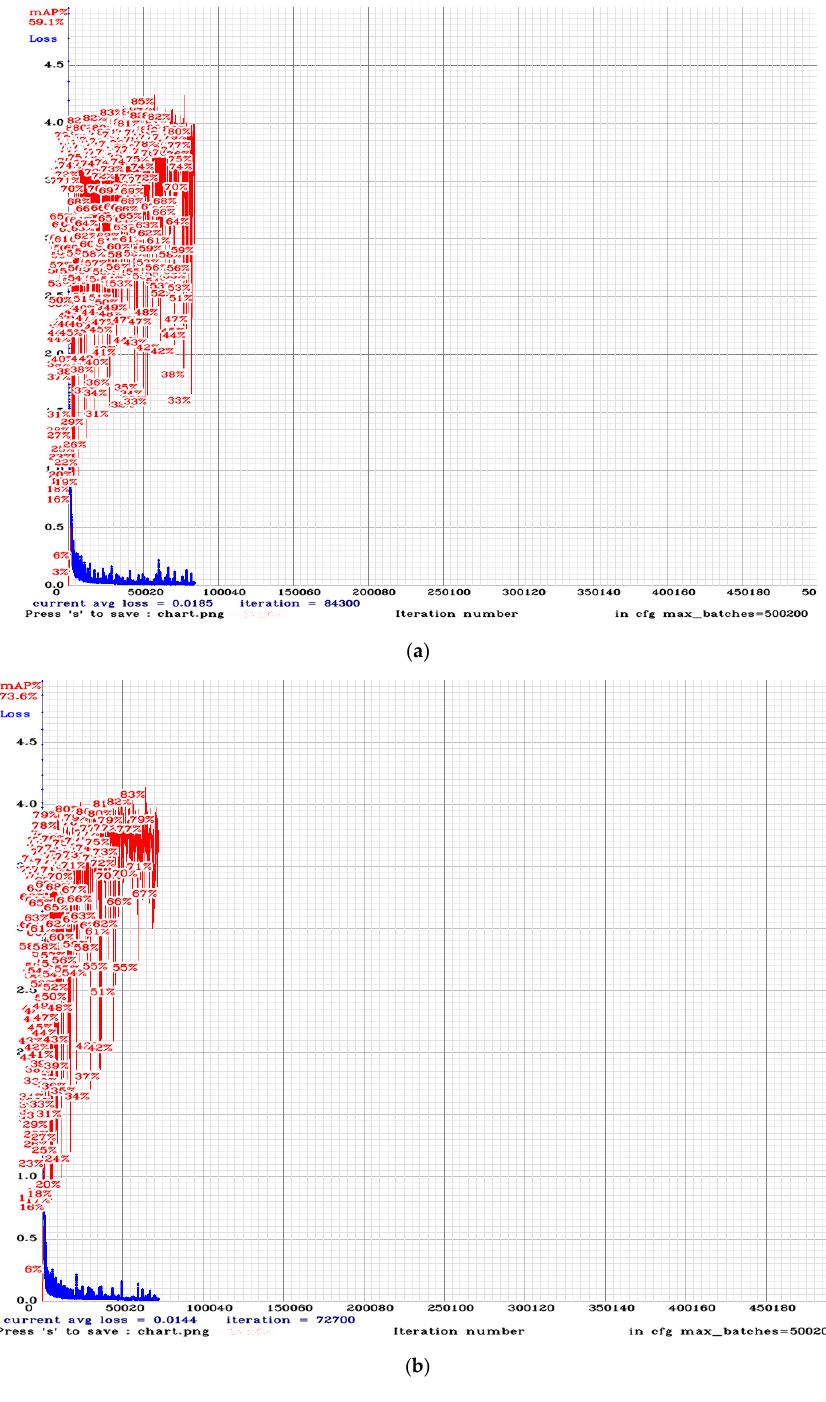
Figure 8. Training loss value, mAP, and AP performance for all classes using Tiny Yolo V3 ( a ) and Tiny Yolo V3 SPP ( b ).